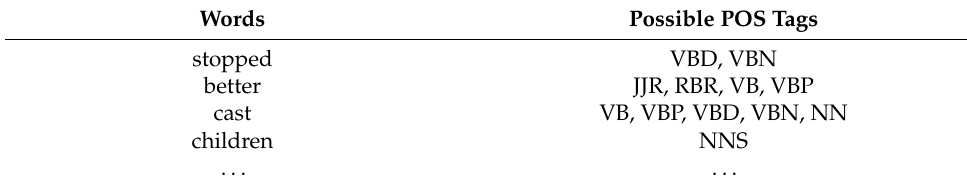
Table 3. The cached POS